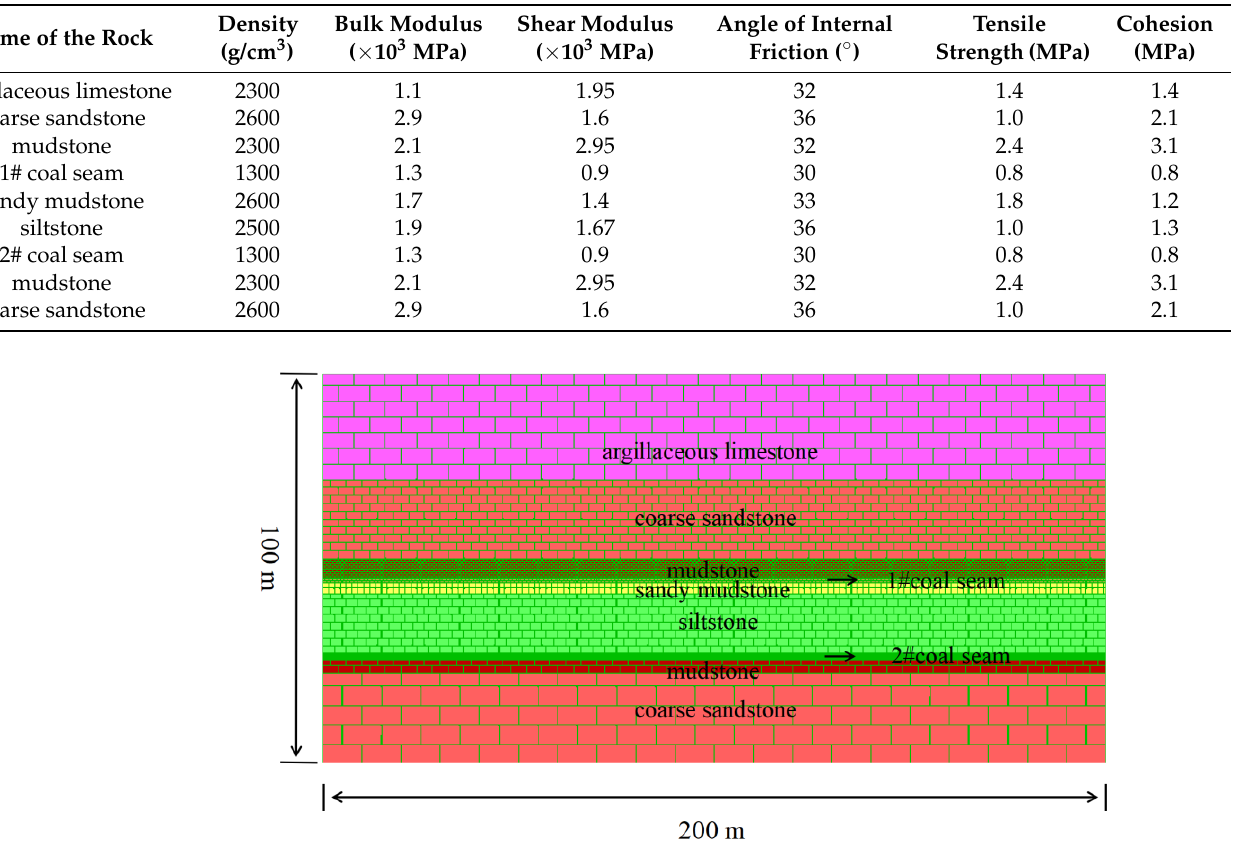
Figure 3. Numerical simulation calculation model .